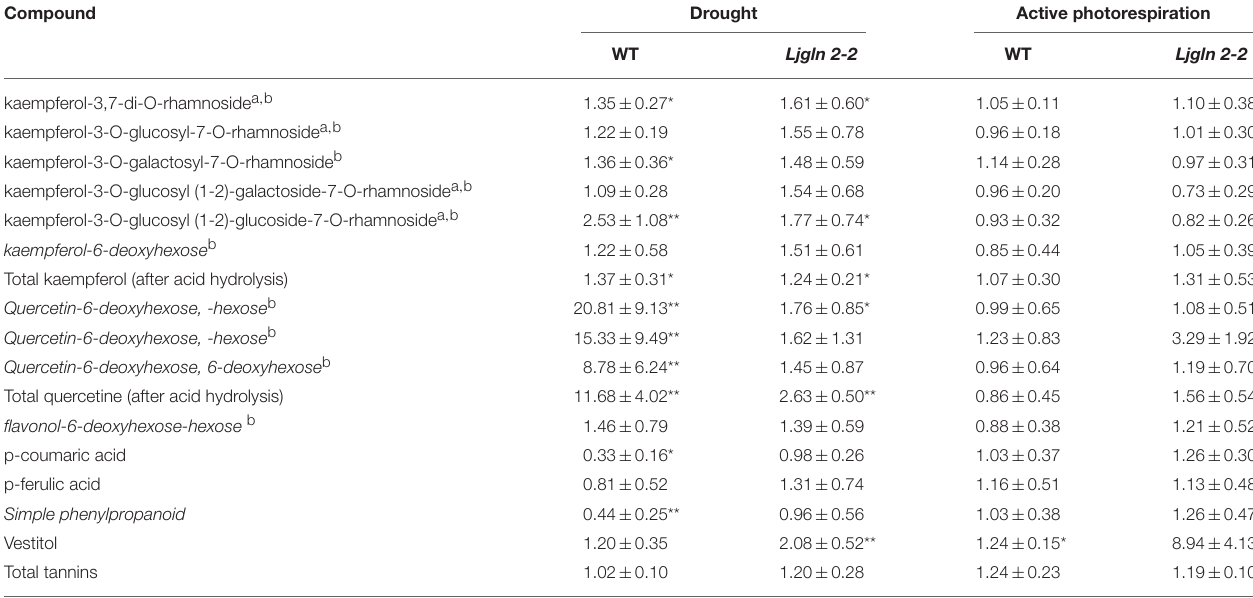
TABLE 5 | Relative changes of phenolic compounds under drought or active photorespiratory conditions. Compound Drought